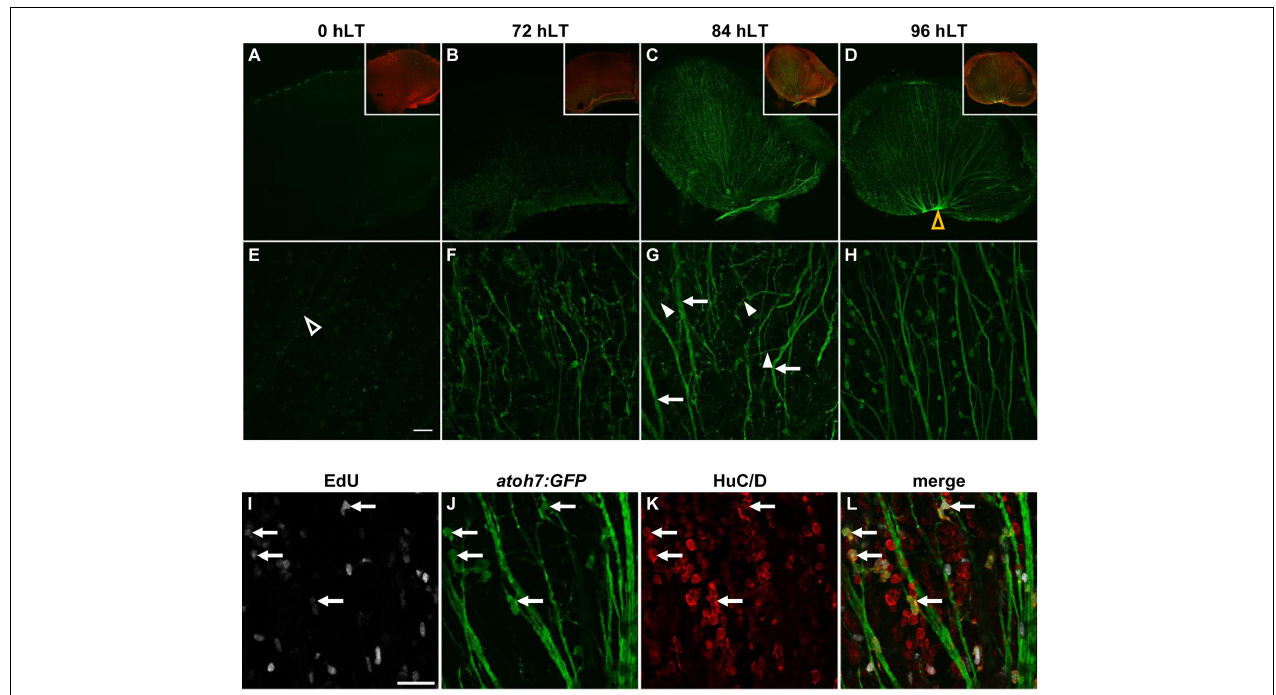
FIGURE 3 | Newly generated ganglion cells extend axons. (A–H) Confocal images of dorsal retinal flatmounts from light-damaged Tg[atoh7:GFP]rw021 zebrafish (0, 72, 84, 96 hLT) immunolabeled for GFP (A–H) and phosphorylated gap43 to identify the nerve fiber layer (A–D , inset) at lower (A–D, single z -plane ) and